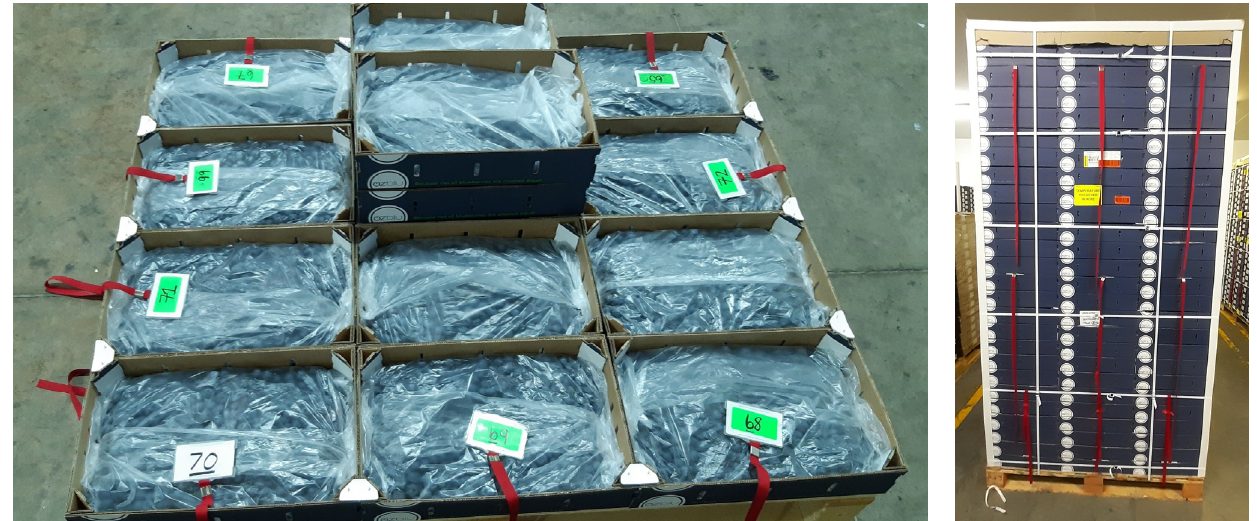
Figure 4. iButtons ® placed in cartons during building of pallets at the packhouse . Source: [13].